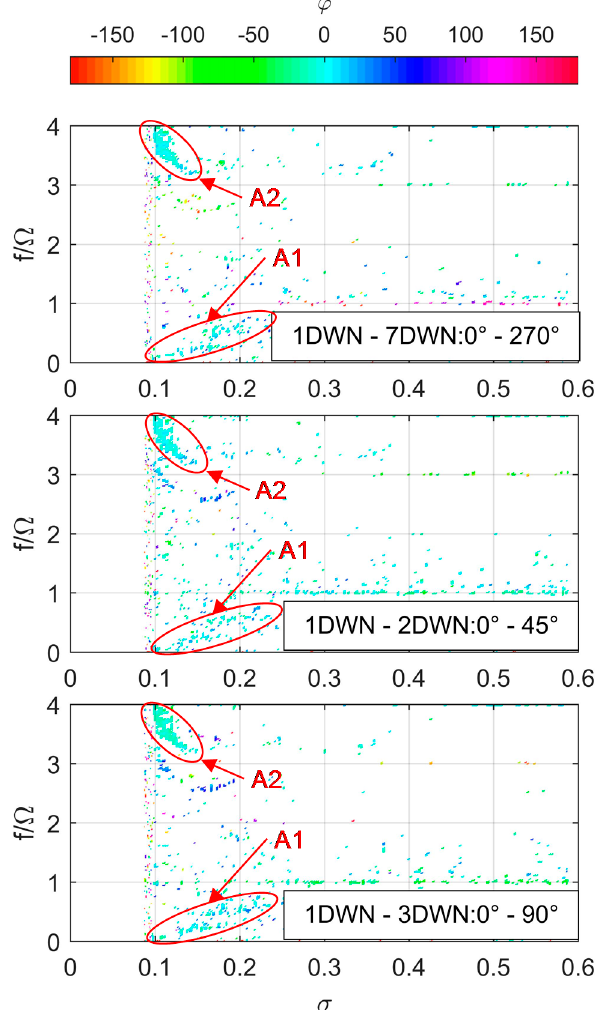
Figure 12. Cross-spectrum phase ( ϕ ) of the downstream pressure transducers, Φ = 0.108 (90% Φ D ). Red circled phenomena are summarized in Table 8.